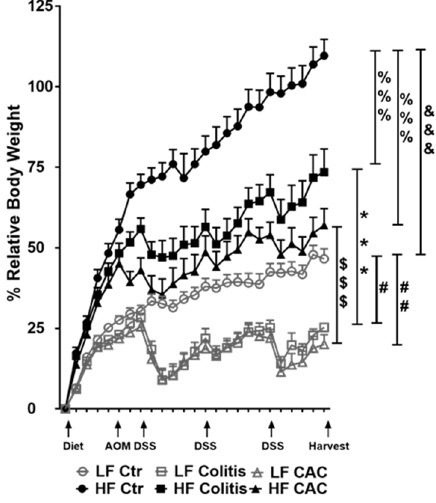
Figure 2. High-fat feeding protects mice from losing body weight upon DSS exposure. Relative body weight change is depicted as a percentage of starting day of diet feeding (day 0). Significances were determined using ANOVA with post-hoc corrections. *** p < 0.001 HF-CAC vs. LF-CAC; # p < 0.05 and ## p < 0.01 LF-Colitis or LF-CAC vs. LF-Ctr; %%% p < 0.001 HF-Colitis and HF-CAC vs. HF-Ctr;